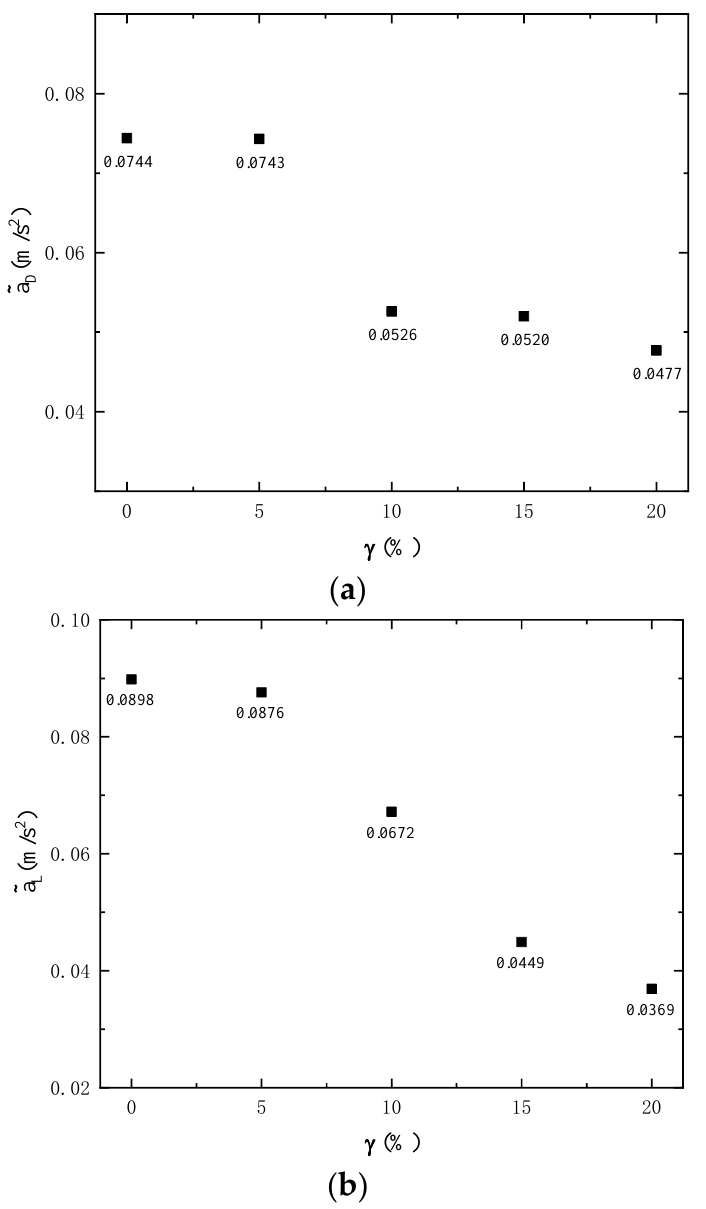
Figure 15. The peak acceleration at the top floor of the buildings. ( a ) Along-wind direction. ( b ) Across-wind direction. Figure 16 illustrates the mean along-wind wind loads. The mean along-wind wind load of high-rise buildings decreases first and then increases with increasing of the corner set-back rates. The maximum reduction of mean along-wind wind loads happens at a corner set-back rate of 10%, and the overall along-wind mean wind loads is decreased by about 50%. This phenomenon is consistent with the variation trend of the mean drag force coefficients and mean along-wind base moment coefficients. As the mean across-wind wind loads are almost zero, and the across-wind mean wind loads is not discussed in this